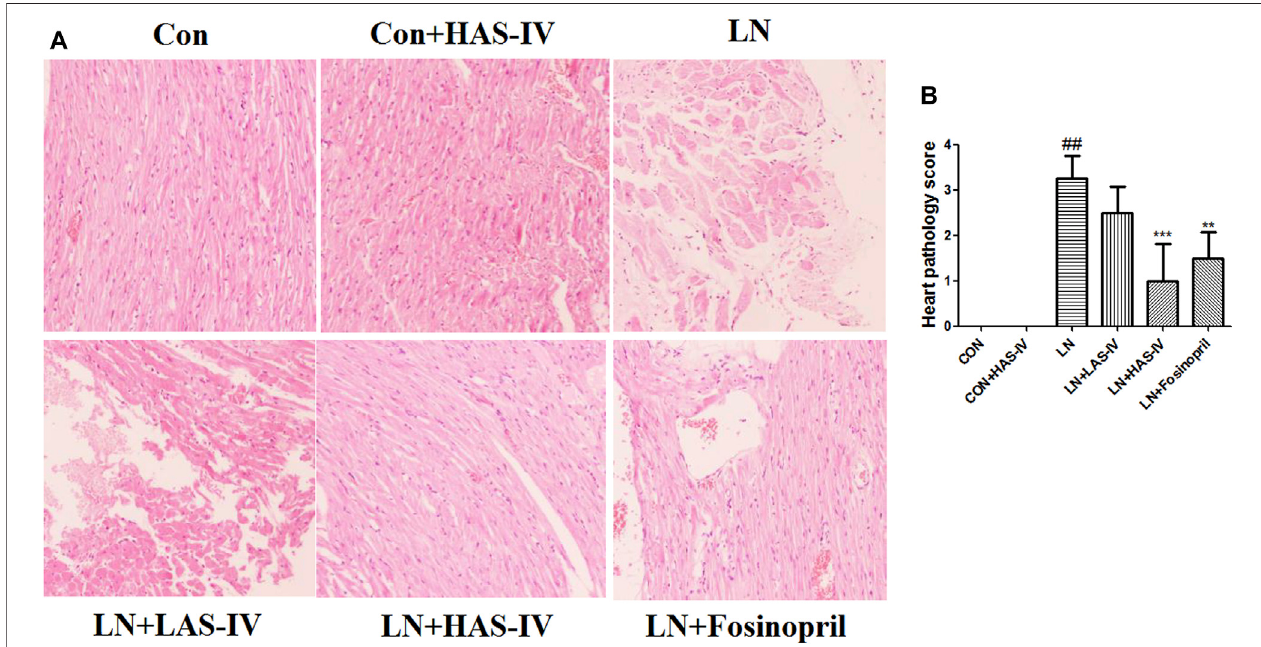
FIGURE 6 | Effects of Astragaloside IV (AS-IV) on cardiac tissue histopathological changes in hypertensive rats. Results were shown as mean ± SD ( n (cid:1) 6 for each group). ## p < 0.001 versus CON group, ** p < 0.01 versus LN group. Hematoxylin and eosin staining method was used to evaluate the cardiac tissue histopathological changes. (A) Cardiac pathological score (B) . Scale bar (cid:1) 100